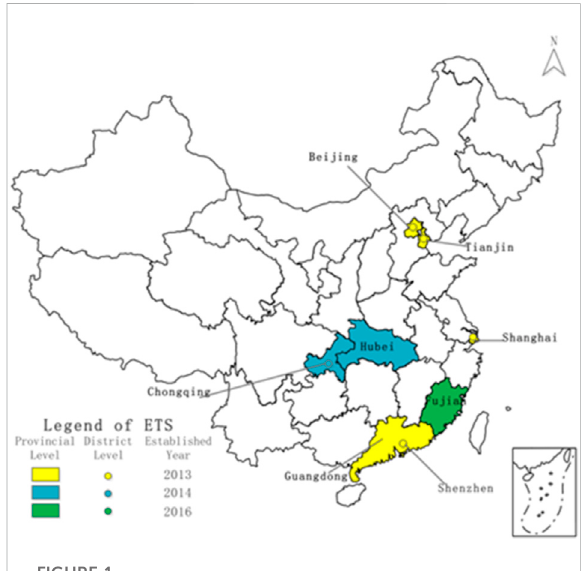
FIGURE 1 Distribution of China ’ s carbon emission trading pilot regions.